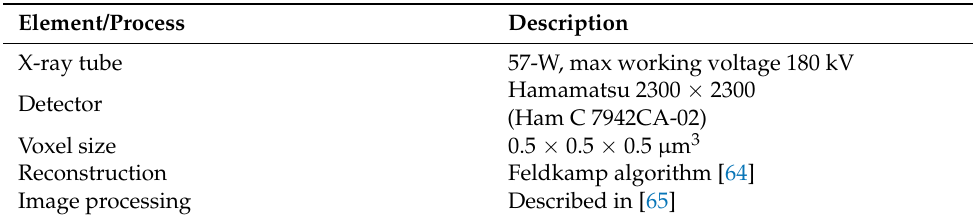
Table 1. Specification of Nanotom S 180n General Electric Sensing & Inspection Technologies, image reconstruction, and processing